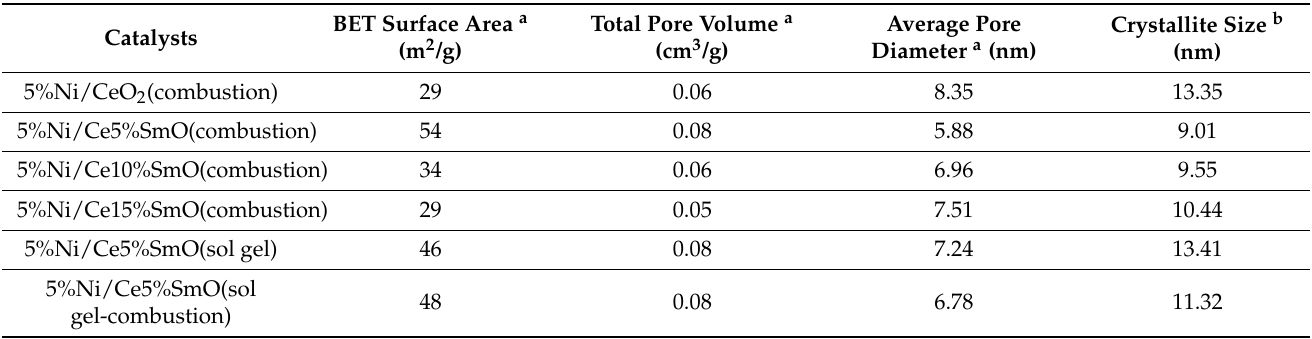
Table 1. BET surface area, average pore diameter and total pore volume of Ni-based catalysts prepared by different